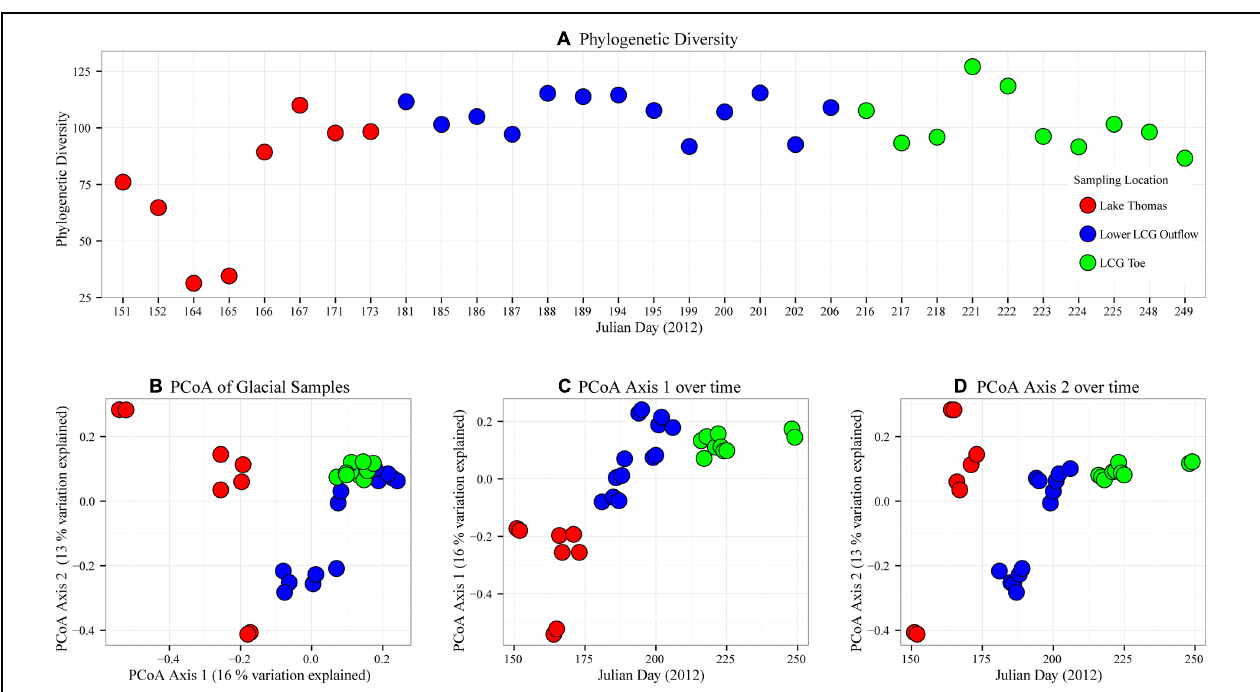
FIGURE 4 | Temporal microbial community diversity patterns at LCG. Prior to calculation of alpha and beta diversity, rare OTUs ( < 2 occurrences) were removed and the OTU table was subsampled to a uniform depth of (1354 sequences). In all panels sampling location is indicated by color; lower Lake Thomas (red), lower outflow stream (blue), and glacial terminus